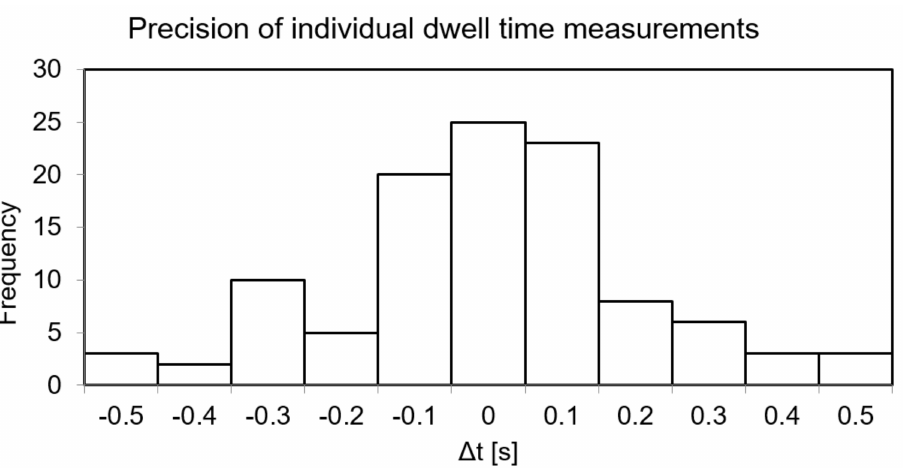
Figure 5. Histogram of the absolute deviations between planned and measured dwell times. The binning is 0.1 s based on the PRO-DOSE acquisition frequency